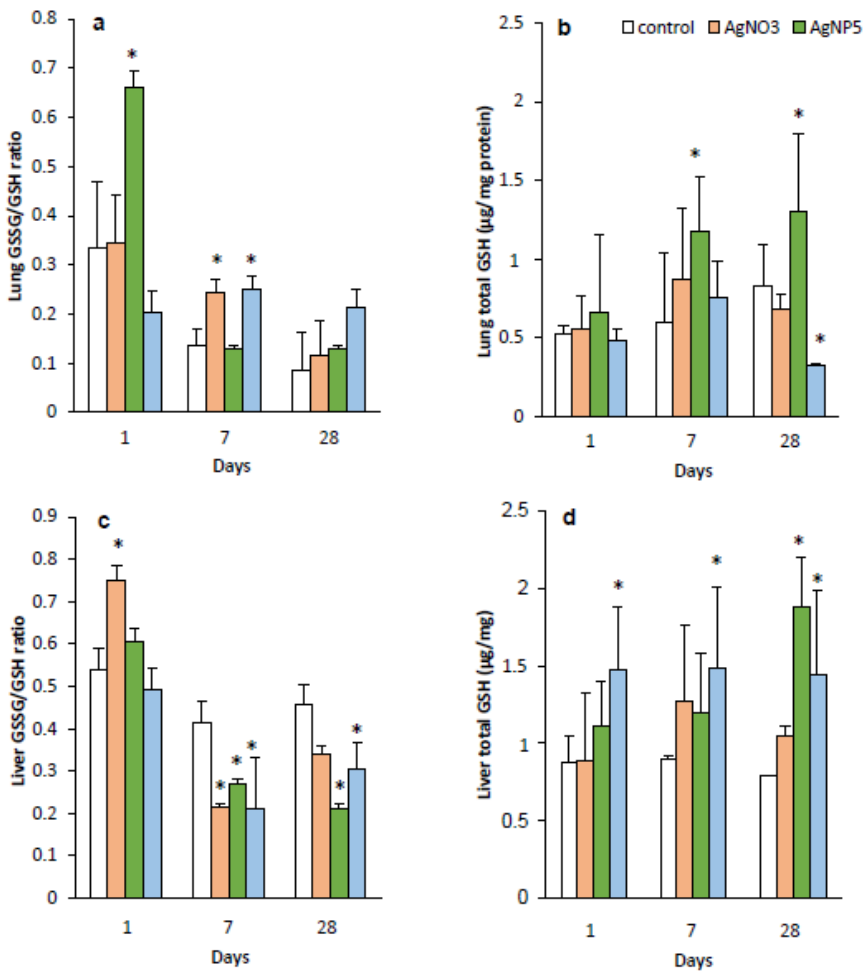
Figure 6. GSH and GSSG levels ( µ g/mg protein) and GSSG:GSH ratio analysis during a 28-day re- covery time after repeated intratracheal instillations of saline (control), AgNO 3 , AgNP5 and AgNP50. ( a ) Lung GSSG:GSH ratio; ( b ) lung total GSH; ( c ) liver GSSG:GSH ratio; ( d ) liver total GSH. * means significant differences between the control and treatments (one-way ANOVA; Dunn’s test p < 0.05) ( n = 4).